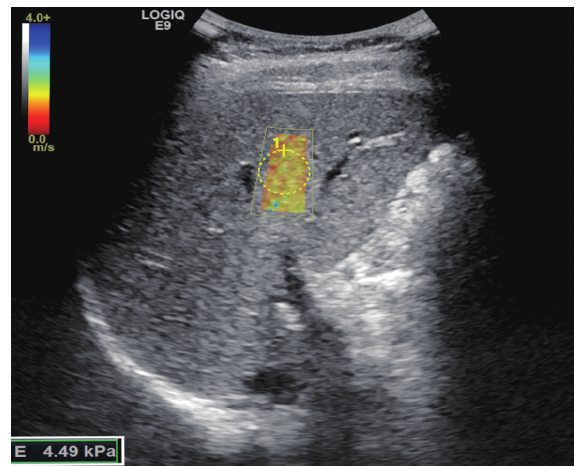
Figure 3 2D-SWE image in a 25-year-old woman in good health. 2D-SWE of the liver performed with the GE LOGIQ E9 system through intercostal access. The measurement is given in kPa. Image demonstrated one of the 10 measurements obtained in the same location. The hardness of the liver is 4.49kPa, which is within the normal